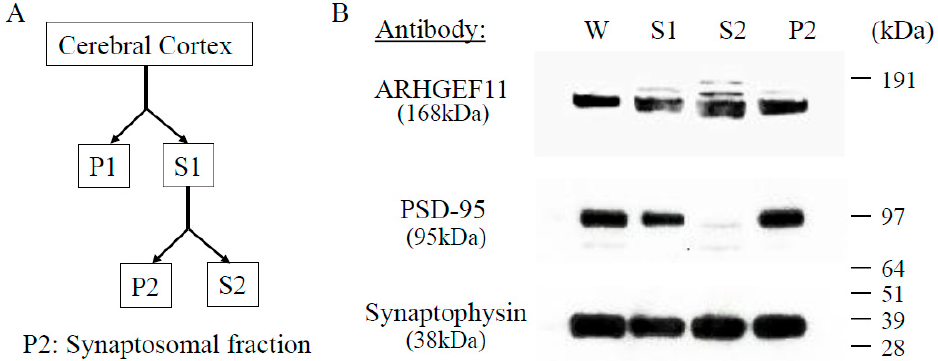
Figure 1. Subcellular distribution and localization of ARHGEF11 in rat cerebral cortex: the method of fractionating cerebral cortex ( A ); and fractions with antibodies against ARHGEF11, synaptophysin, and PSD-95 ( B ). ARHGEF11, synaptophysin, and PSD-95 were detected in the crude synaptosomal fractions (P2); S1 (supernate 1), S2 (supernate 2). P1 (pellet 1).